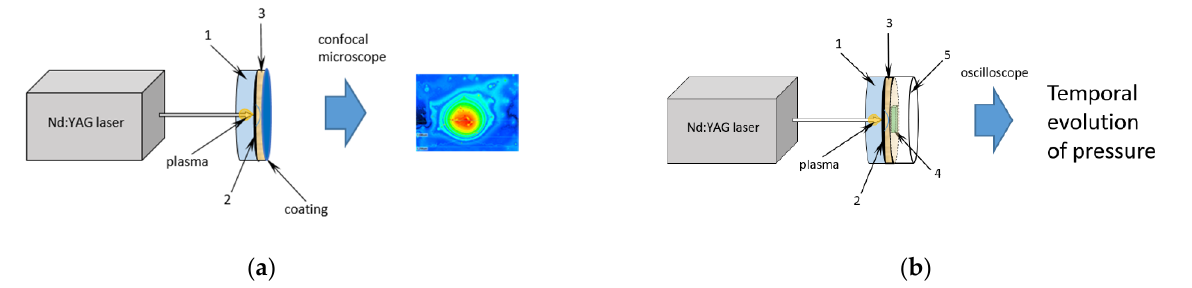
Figure 2. ( a ) Scheme of the experimental set-up for testing shock wave pressures induced by a laser pulse. 1—water, 2—graphite, 3—steel plate, ( b ) Modified set-up for measuring the film adhesion to the substrate by applying laser pulse. 1—water, 2—graphite, 3—steel plate, 4—PVDF sensor, 5—Teflon.